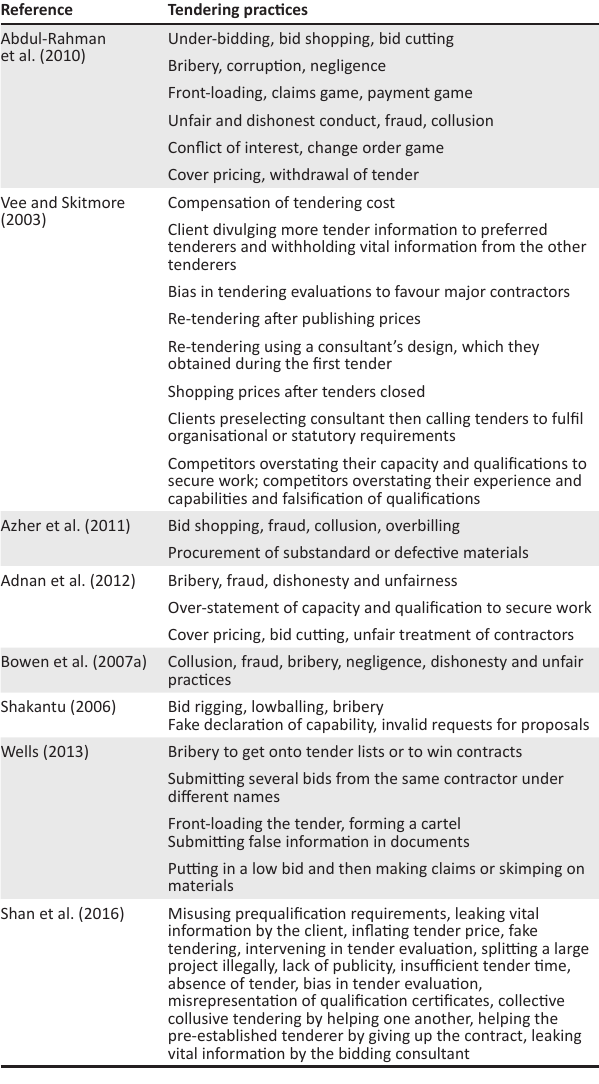
TABLE 1: Unethical tendering practices from previous studies.